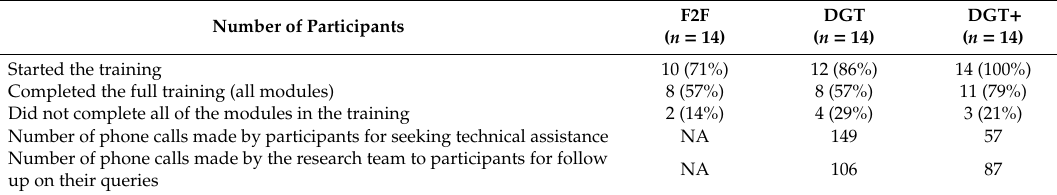
Table 2. Summary of process indicators across the three di ff erent training